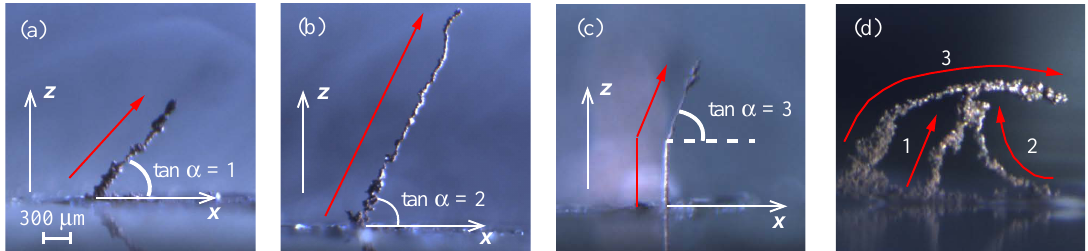
Figure 10. Images of 3D-printed Cu structures with different shapes. Red arrows indicate the movement paths of the print head. ( a ) A tilted pillar with slope tan α = 1, where α is the angle with respect to the x -axis. ( b ) A tilted pillar with slope tan α = 2. ( c ) A vertical pillar followed by a tilted pillar with slope tan α = 3. ( d ) Mixed structure with overhanging features. The numbers indicate the sequence of the printing